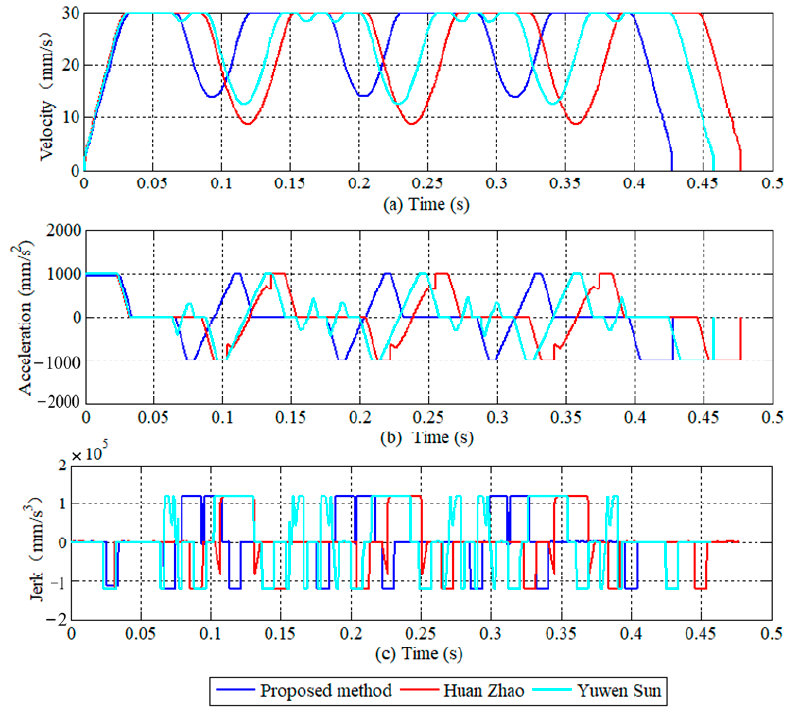
Figure 6. The kinematic profiles ( a ) Velocity profiles. ( b ) Acceleration profiles. ( c ) Jerk